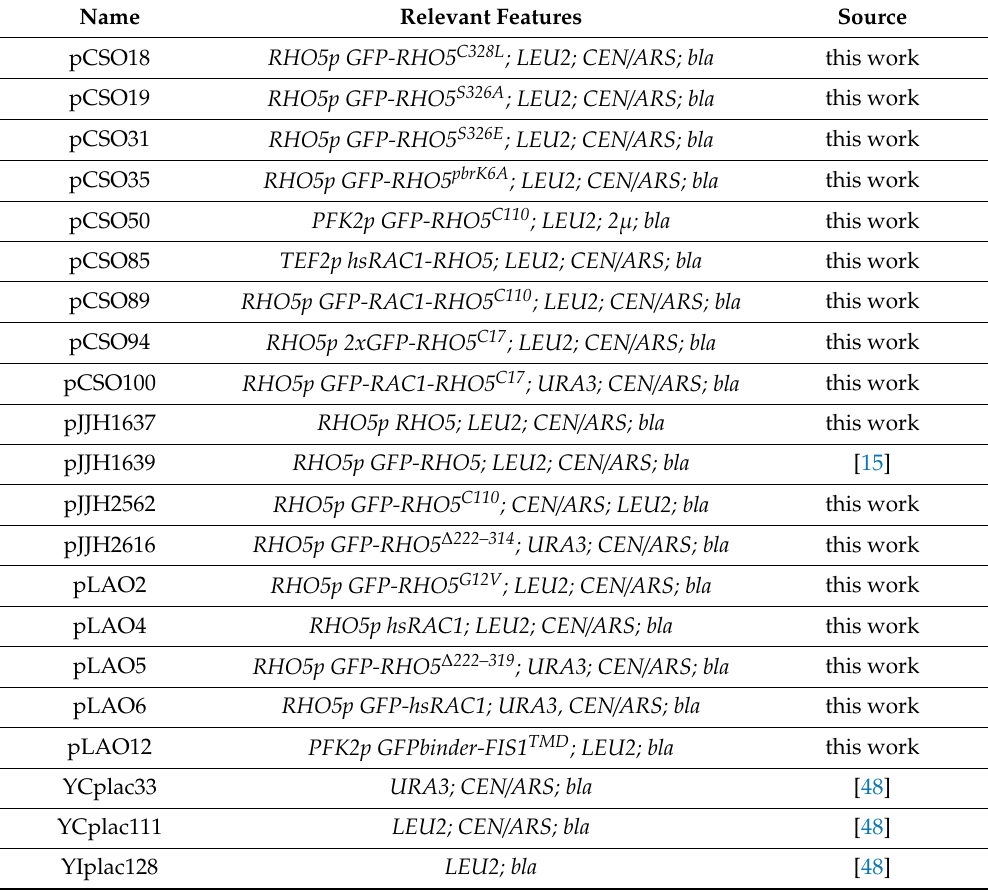
Table 2. Plasmids used in this